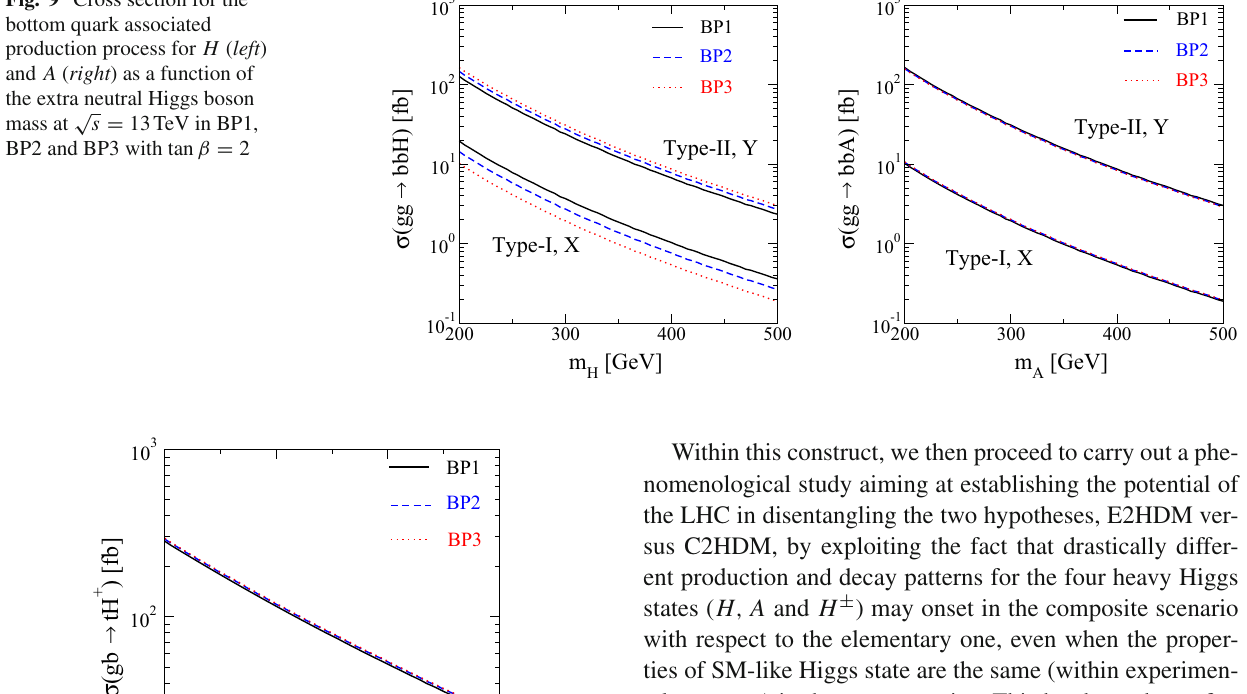
Fig. 9 Cross section for the bottom quark associated production process for H ( left ) and A ( right ) as a function of the extra neutral Higgs boson √ s = 13TeV in BP1, mass at BP2 and BP3 with tan β = 2